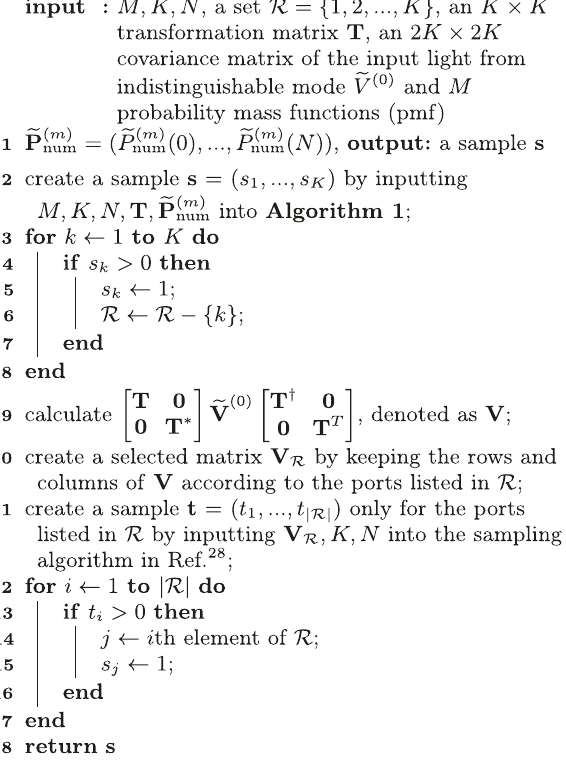
Fig. 3 Approximation fi delity with increasing number of detected photons for a fi xed approximation order. Numerical evaluations of fi delity, Eq. (42) for P approx with number of detected photons N for ( a ) N cut r = 0.9, η ind = 0.9, η t = 0.99. The output pattern for each N is s 1 = ... = s N = 1, s N + 1 = ... = s K = 0, the other choices of output pattern give similar results. These results are obtained over 94 Haar-random unitary